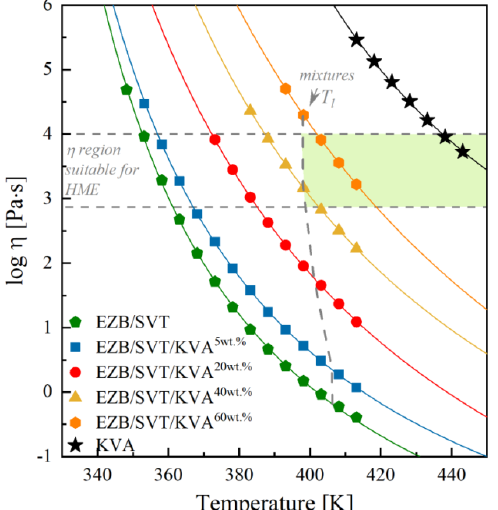
Figure 8. Comparison of the temperature dependences of complex viscosity of KVA ( black stars), EZB/SVT ( green pentagons), EZB/SVT + 5wt. % of KVA ( blue squares), EZB/SVT + 20wt. % of KVA ( red circles), EZB/SVT + 40wt. % of KVA ( yellow triangles) and EZB/SVT + 60wt. % of KVA ( orange hexagons). The solid lines correspond to the VFT fits, dashed horizontal lines denote the upper and the lower range of viscosity suitable for small scale extrusion, and dashed vertical lines represent liquidius temperature of the examined systems, while shadowed area marks the suitable for extrusion region of temperature and viscosity of the EZB/SVT/KVA ternary system.